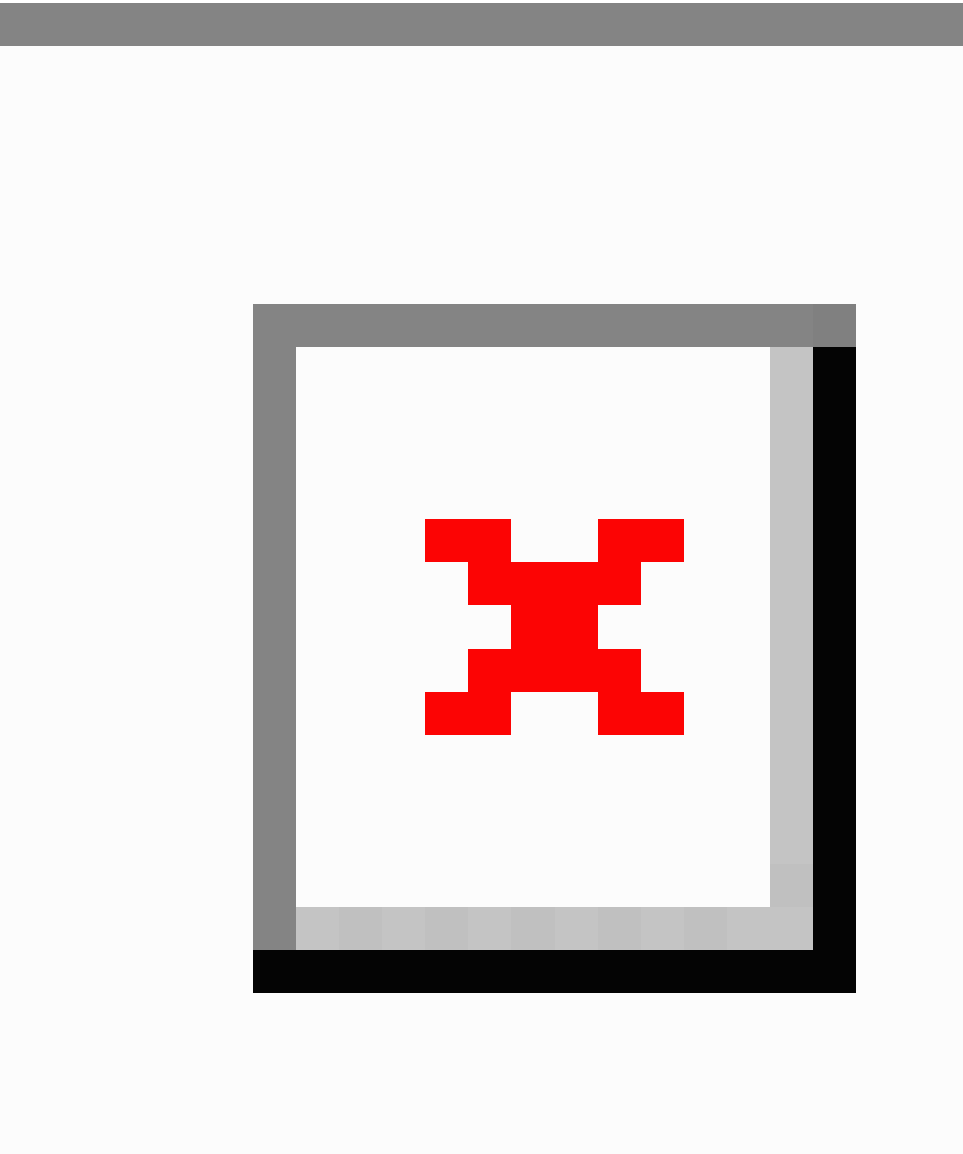
Figure 6. Mental health professionals are to balance ethical concerns with the benefits of mental health mobile apps.